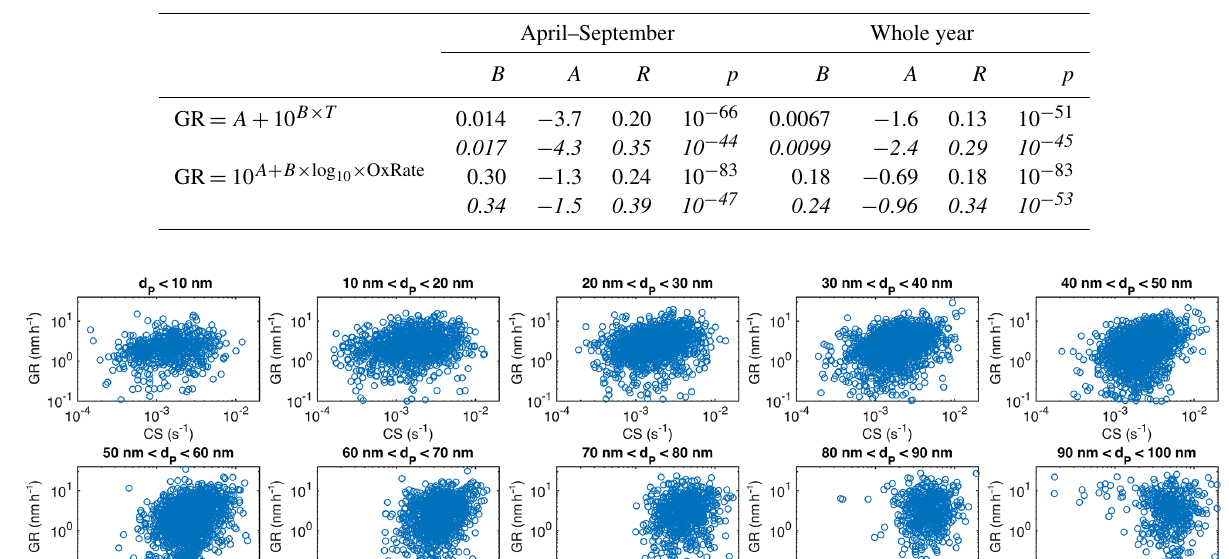
Table 3. Parameters of linear least-squares fits for growth rates starting from d P <100nm as a function of temperature (first row) and monoterpene oxidation rate (second row), and the related correlation coefficients and p values. Upper values are for growth periods with the duration >2h and the lower values in italics for the duration >5h.